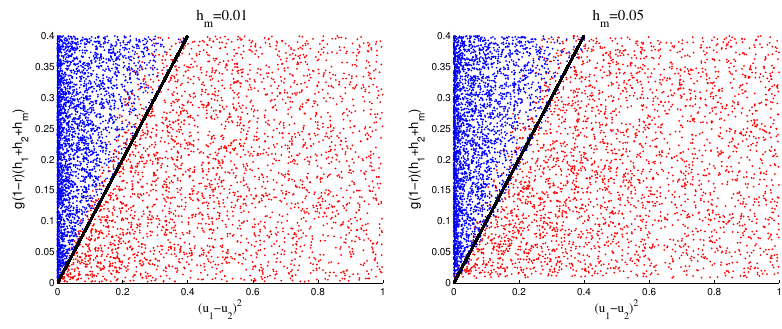
Figure 13. Hyperbolicity check for the three-layer system (2.1) with h m = 0 . 01 (left) and h m = 0 . 05 (right): The blue points represent the range of hyperbolicity.